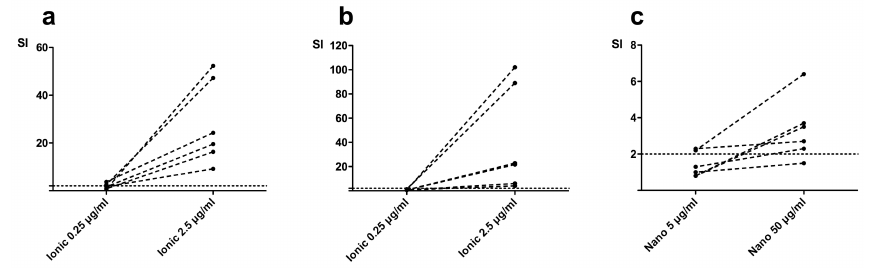
Figure 1. Lymphocyte proliferation (stimulation index (SI) = % of stimulated CFSE positive cells relative to the mean % of unstimulated control cells) of CD4+ cells and CD8+ cells after stimulation with ionic-Ti ( a (CD4+), b (CD8+)) and nano-TiO 2 ( c (CD4+)). ( N =